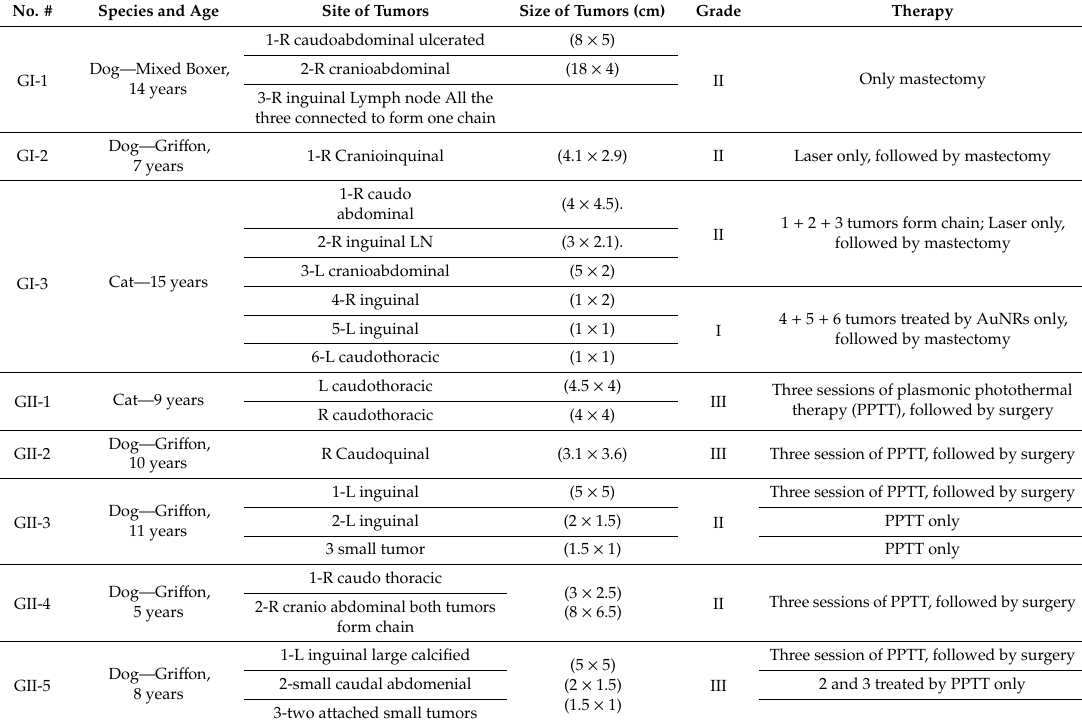
Table 1. Animal groups, tumor clinical features, and therapeutic approaches.